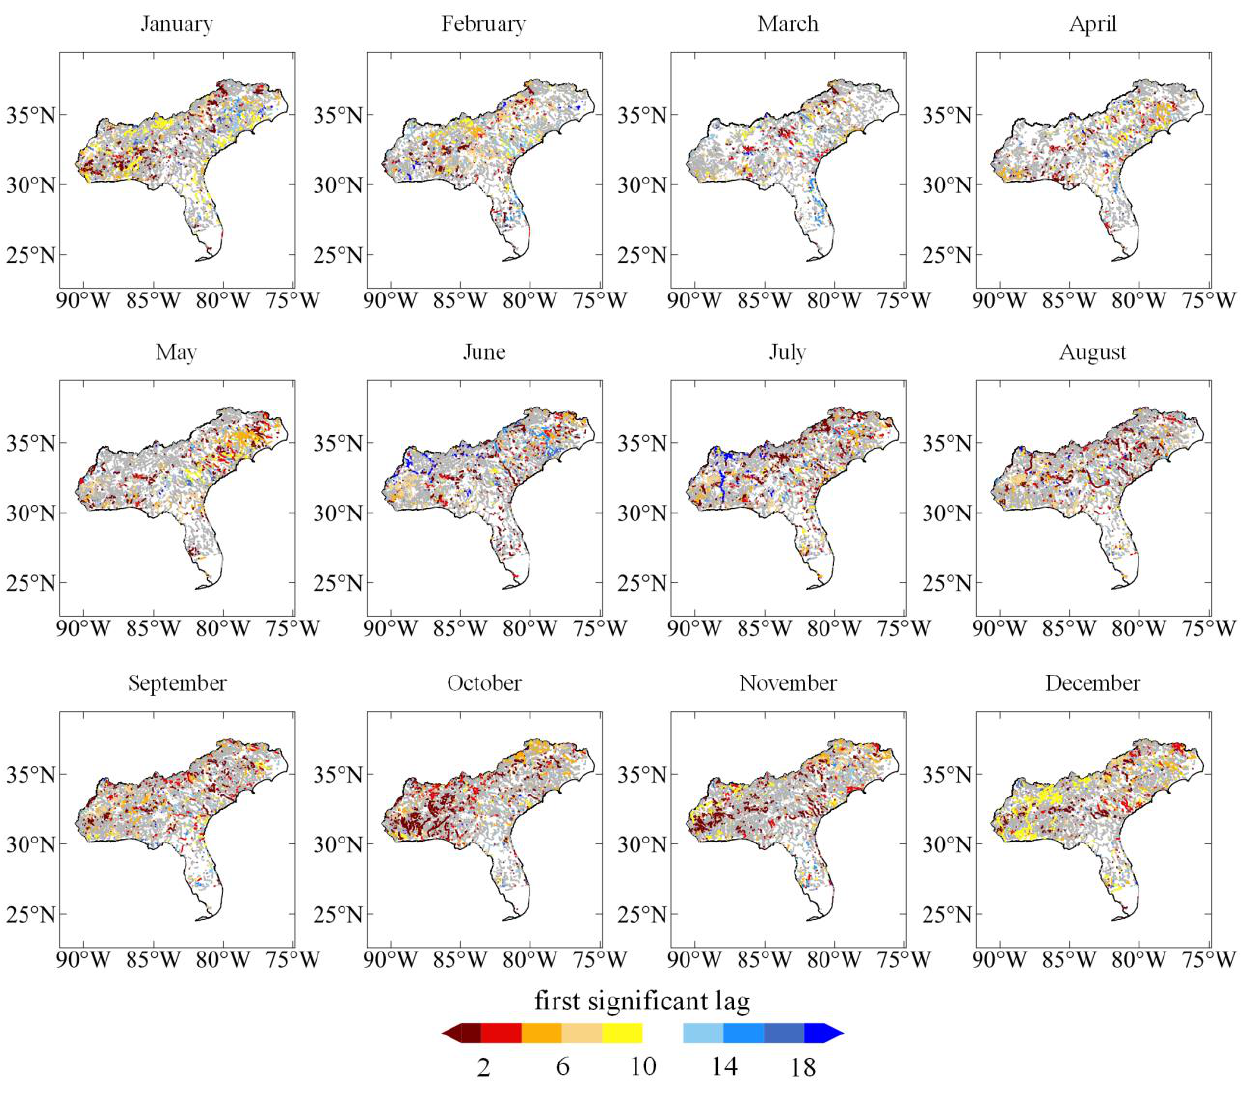
Figure 7. First significant lag in monthly ACF distributions.